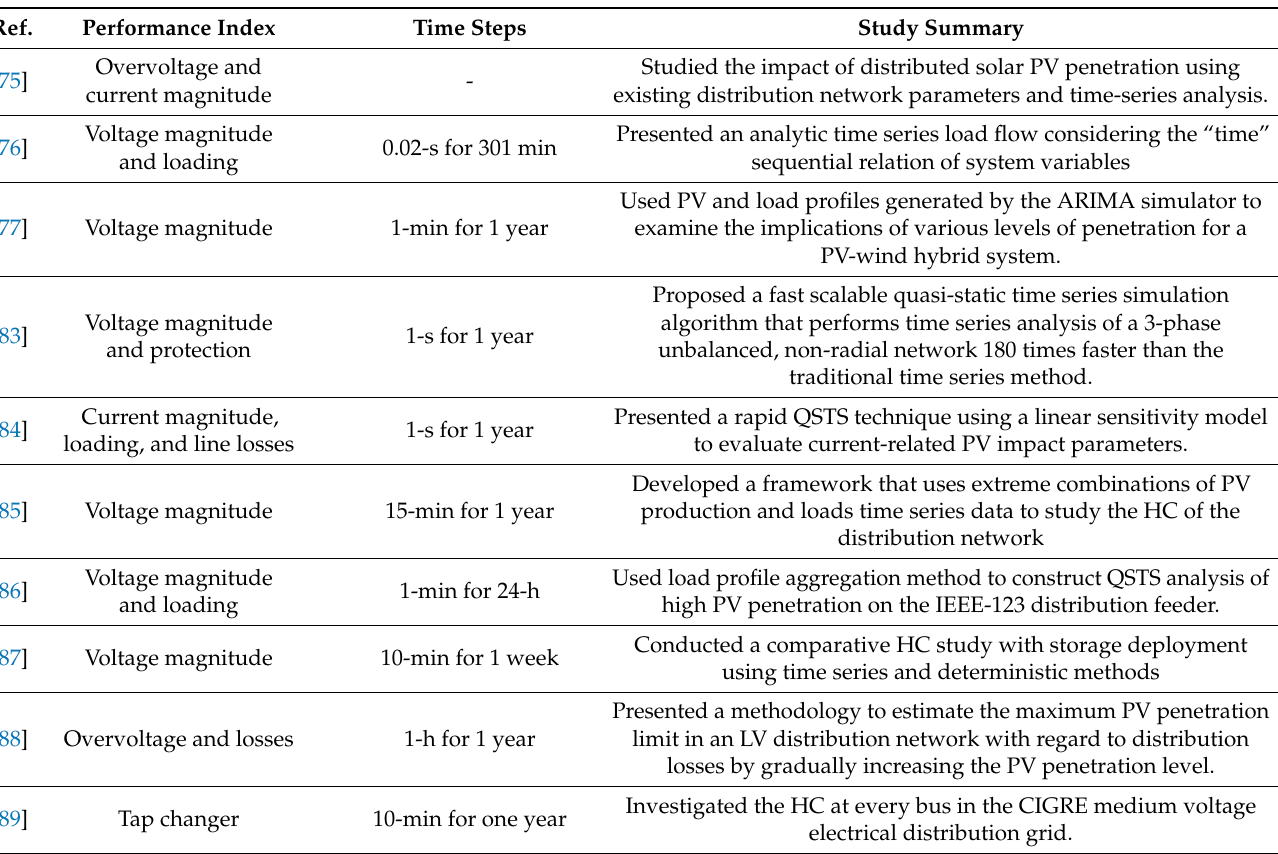
Table 3. Summary of studies that adopts the time series method for PV hosting capacity